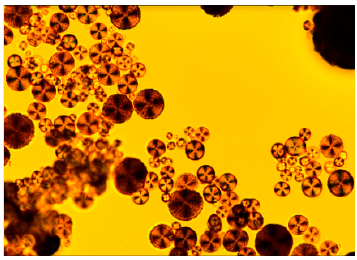
Figure 8. Polarized microscopy image of L-glu spheres crystallized with calcium ions.